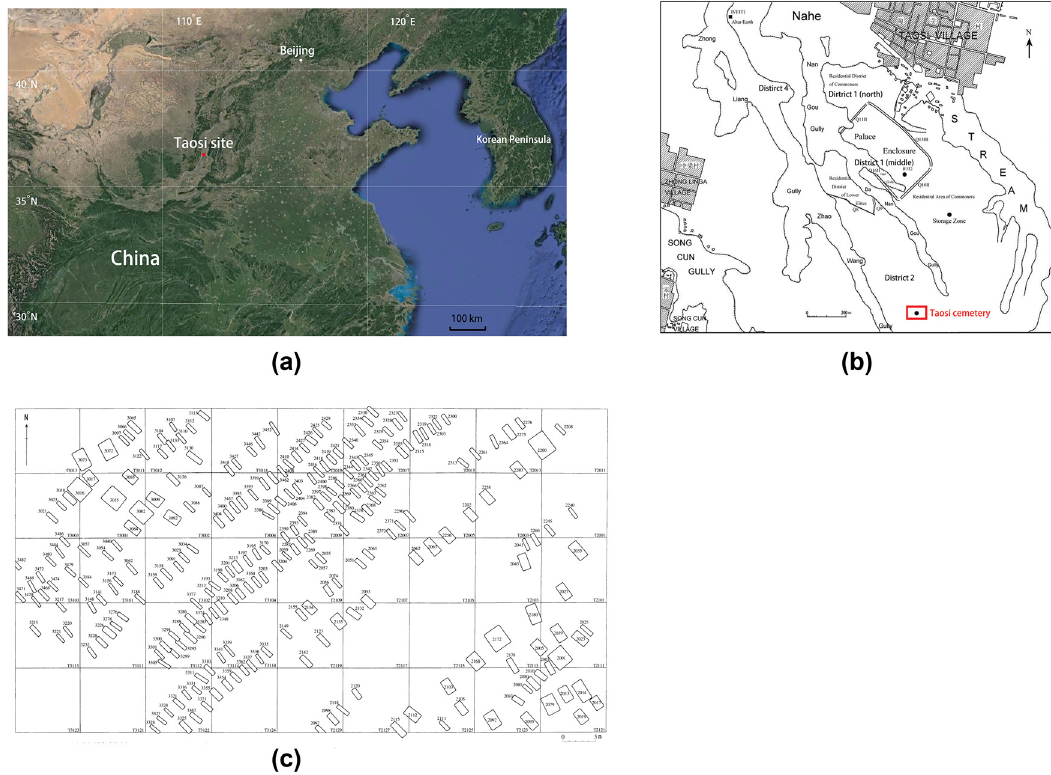
Figure 1: The location of the Taosi site ( a ) and Taosi cemetery ( b ) and ( c ) the layout of the Taosi cemetery in the early